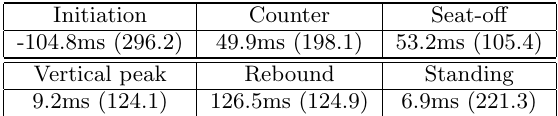
Table 1: The mean ( stdev ) of differences in event times (milliseconds) from ground truth. Total mean: 16.5ms. To- tal stdev: 206.4ms